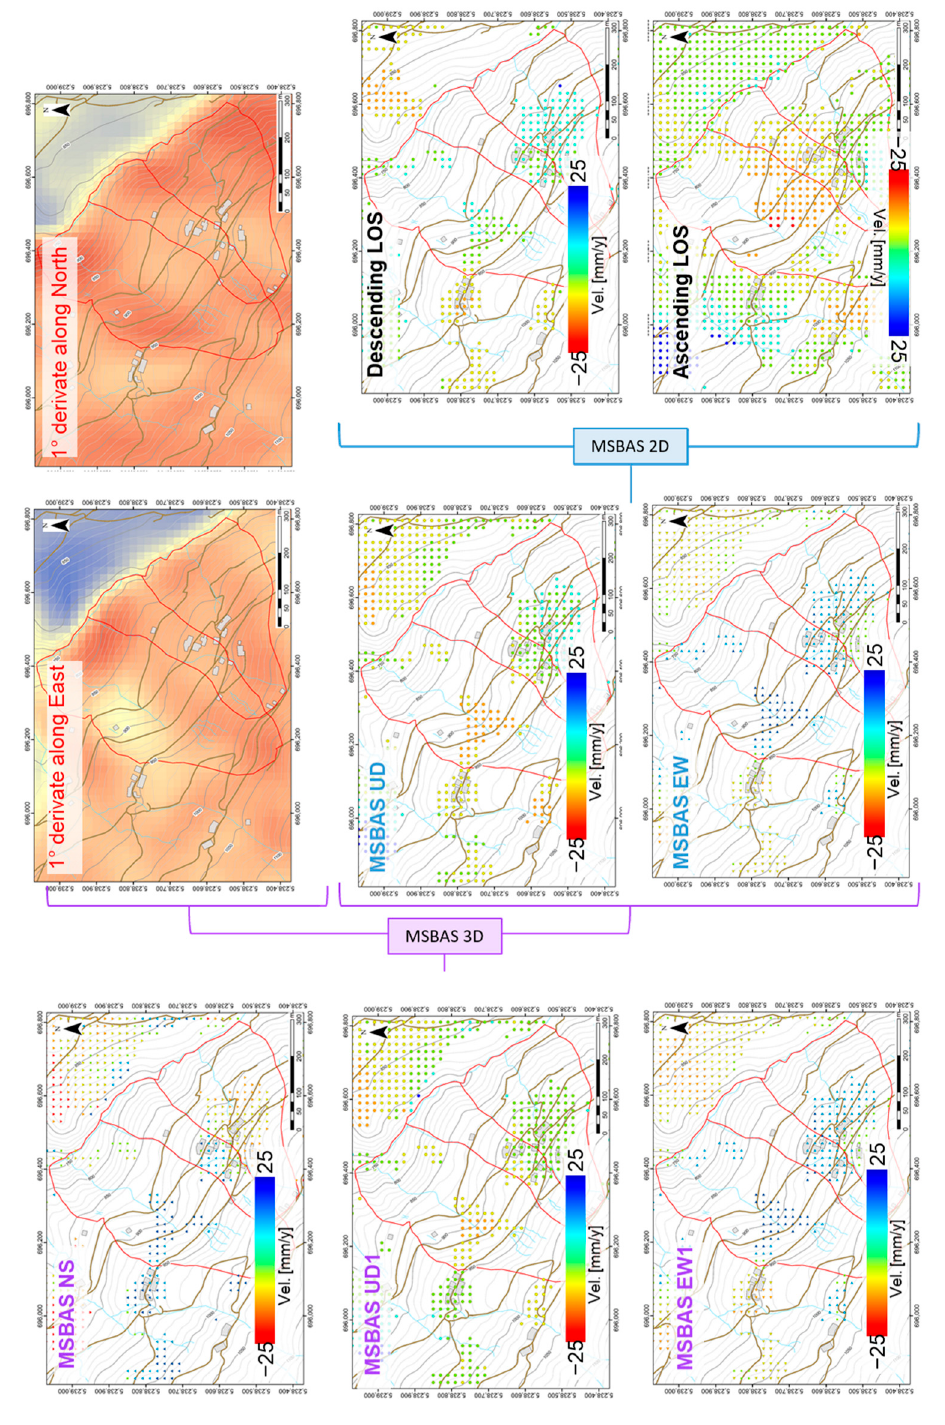
Figure 2. MSBAS 2D and 3D workflow adopted to process the ascending and descending data image stacks acquired by Sentinel ‐ 1 radar sensor.